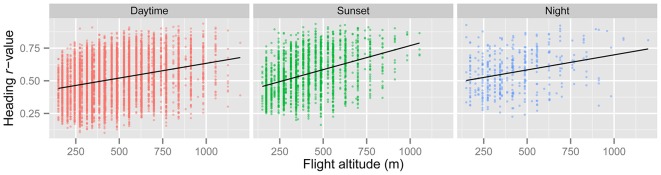
Regression of r (a measure of angular dispersion around the mean flight heading) against insect flight altitude for the “migration events” during the three time periods. Higher values of r denote occasions with greater orientation “performance” (i.e., tighter orientation around the mean). There is a highly significant positive relationship between r and flight altitude in all three periods (see Table 5), indicating that insects orient their flight headings with respect to the downwind direction better at higher altitudes.